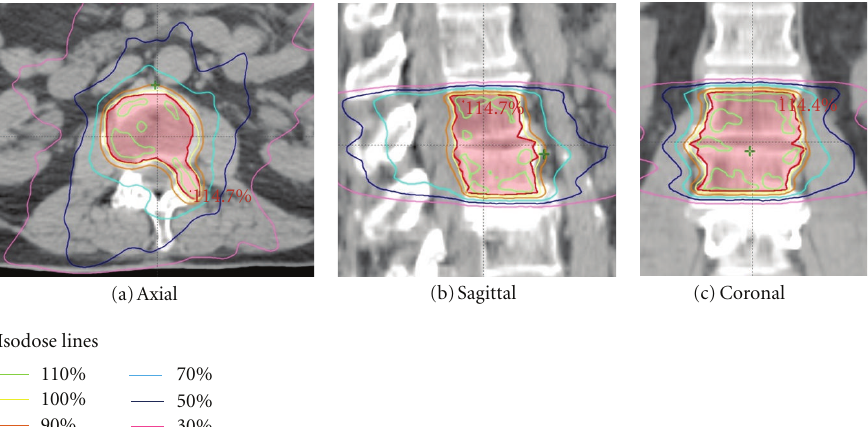
Figure 1: Dose distribution for a patient treated with spinal radiosurgery to L1-L2. The planning target volume (PTV) is outlined in red.